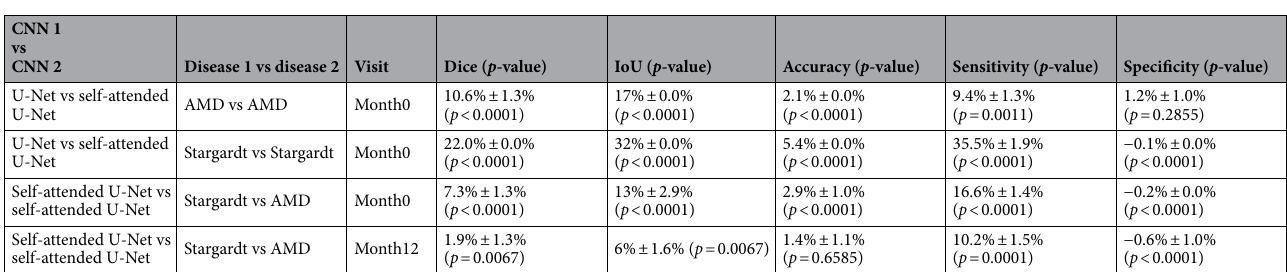
Table 2. Percent differences and Mann–Whitney test results between different CNNs for different diseases. Percent difference defined as (CNN2 − CNN1)/CNN1 . Mann–Whitney test results are indicated by the p